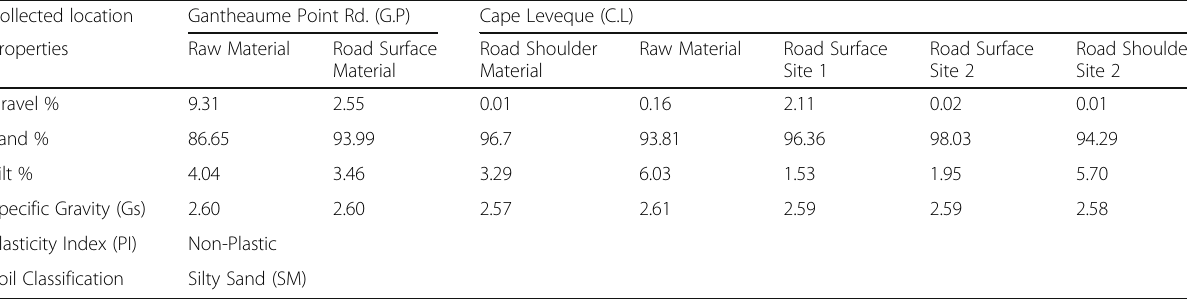
Table 3 Index and Classification of Broome-Pindan Soil Collected location